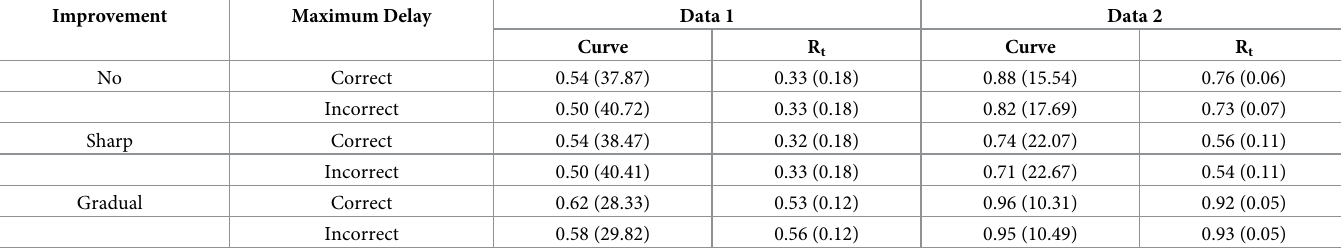
Table 3. Performance measures for an ongoing epidemic wave. The results were averaged over all simulated datasets and dates for both the epidemic curve (Curve) and the reproduction numbers (